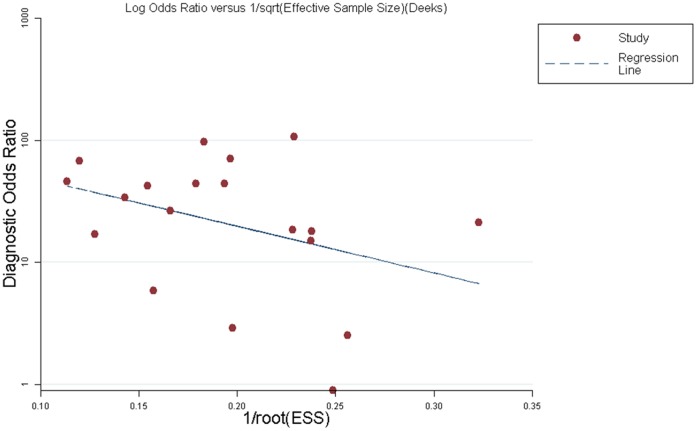
Funnel plot for the assessment of potential publication bias of the 19 included studies.The funnel graph plots the log of the diagnostic odds ratio (DOR) against the standard error of the log of the DOR (an indicator of sample size). Solid circles represent each study in the meta-analysis. The line indicates the regression line. There was no potential publication bias.